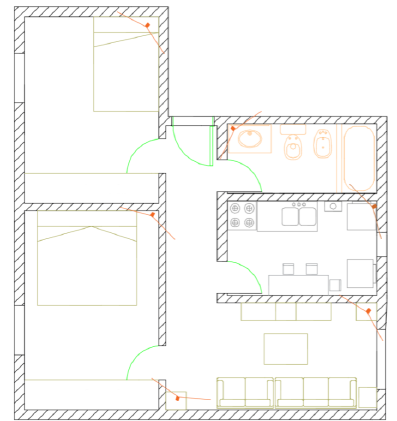
Figure 11. Example of system installation in a